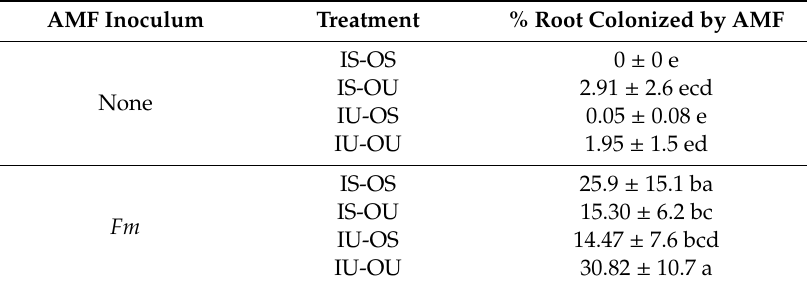
Table 2. Impact of soil compartment sterilization on AMF colonization.